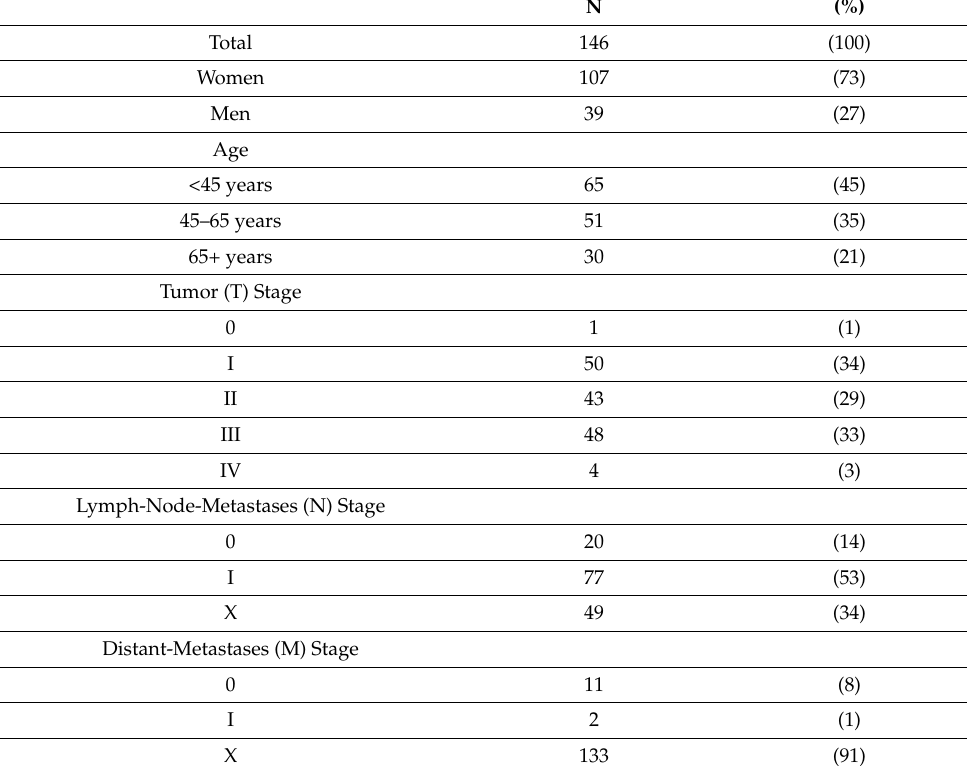
Table 1. Clinical characteristics of study population with differentiated thyroid